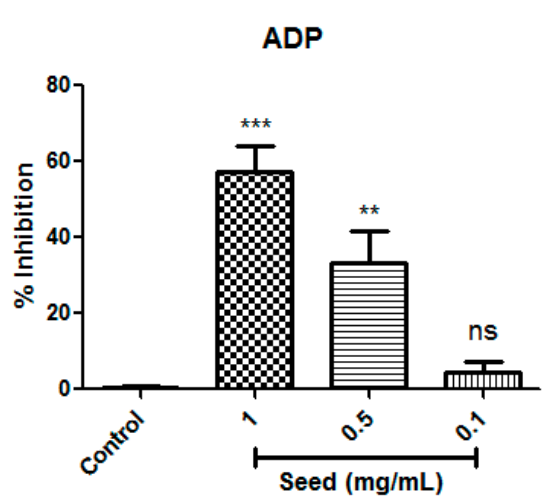
Figure 2. Study of the dose-dependent effect of mango seed extract on antiplatelet aggregation activity against ADP agonist (4 µM) expressed as a mean value of inhibition percentages ( n = 6). Data were analyzed using ANOVA of one factor. Post hoc analyses were conducted by Tukey’s test, ** and *** denotes significant differences at p = 0.01 and p = 0.001, respectively; ns denotes no statistical differences.